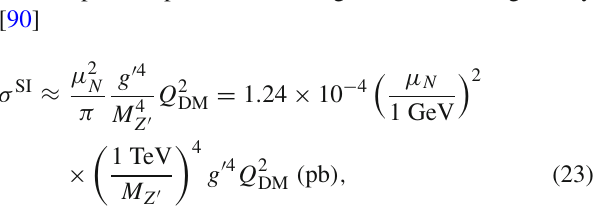
g (cid:2) is determined by yielding correct relic density (cid:20) h 2 (cid:5) 0 . 12. Experi- scattering on 1 = 1TeV, Q = − 1 , − 4 , 3 mental bounds come from XENON1T2017 (green) [87], PandaX2017 . H 0 1 4 2 (pink) [88], and XENON1T(2t · y) (brown) for M Z (cid:2) = 2 , 4 , 6 TeV, Q = − 1 . Here, H 0 1 4